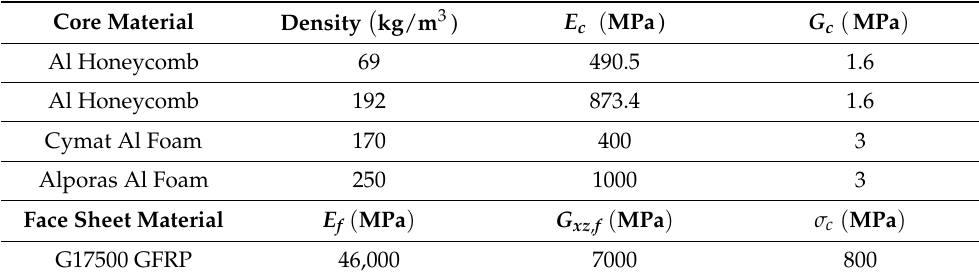
Figure 4. Different types of cores used in this study.